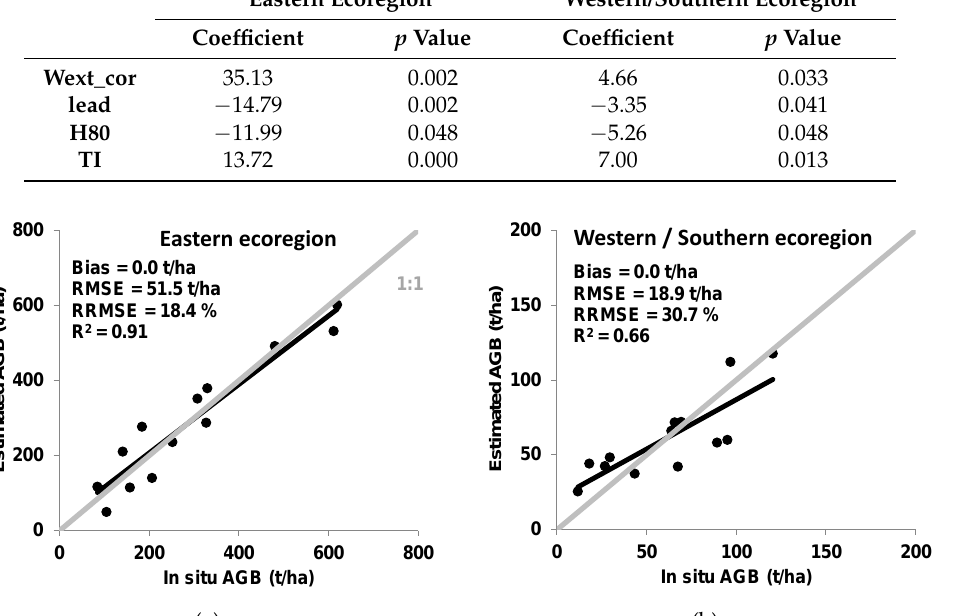
Table 1. Coefficients and p -values of each significant variable.